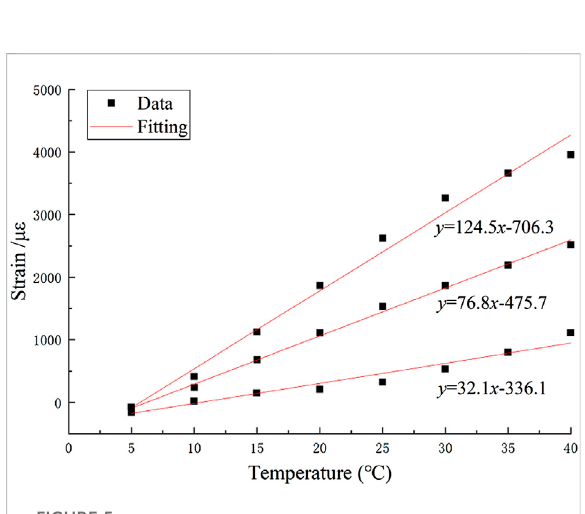
FIGURE 5 Fitting of temperature vs. strain of a strain gauge in a HI